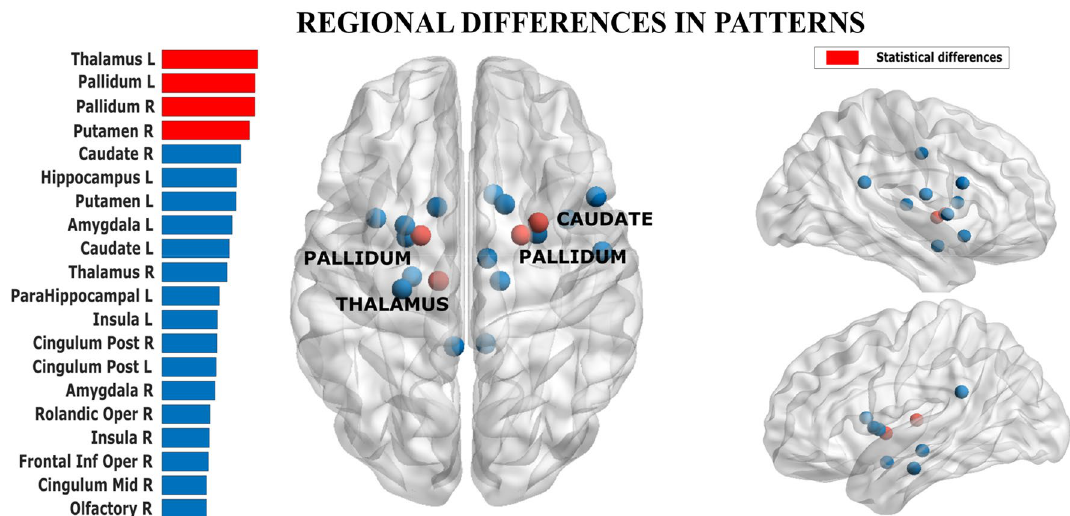
Figure 4. Mapping regional contribution to functional repertoire. The regions that contributed most often to avalanche patterns that were unique to one group. In the bar plot on the left, the width of the bar corresponds to the group difference in frequency with which a region contributed to the avalanche patterns that were unique to a group. The image was done using MatlabR2019a, including BraiNetViewer v. 1.62—http://www.nitrc .org/proje cts/bnv/), and Inkscape